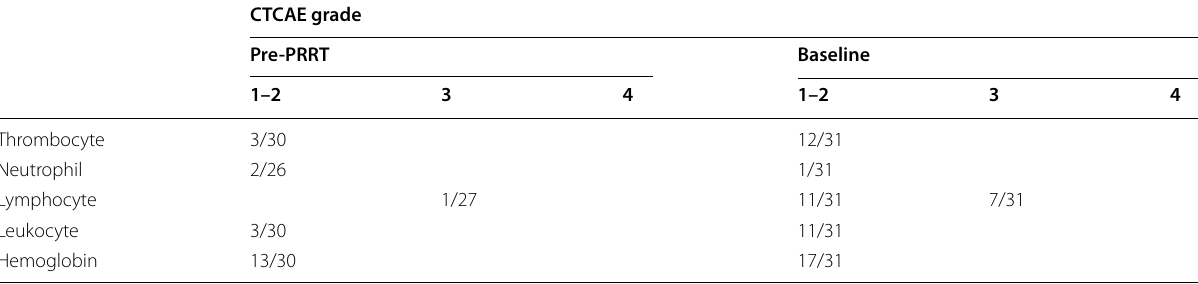
Values are n/available observed patients with the designated toxicity